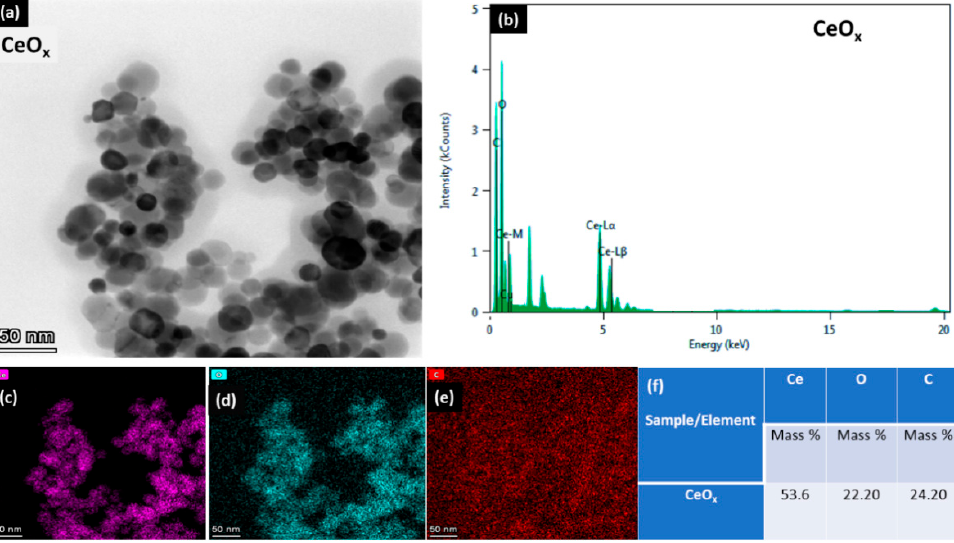
Figure 2. TEM image ( a ), elemental spectra ( b ), EDS mapping ( c – e ), and relative atomic of the elements in the as-synthesized catalyst ( f ).